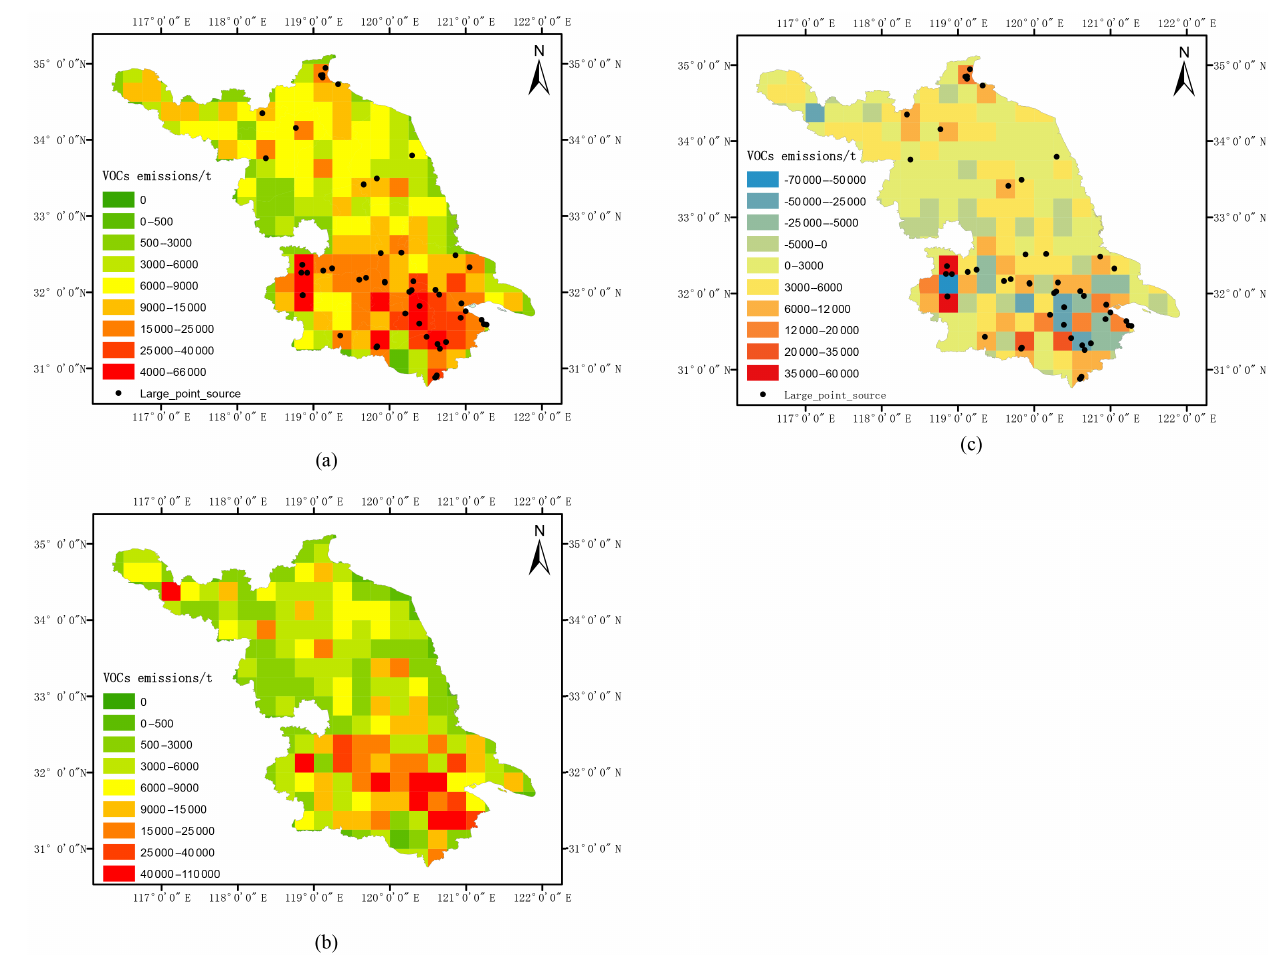
Figure 9. Spatial distributions of Jiangsu’s anthropogenic NMVOC emissions for 2010 (0.25 ◦ × 0.25 ◦ ) by this study (a) and MEIC (b) , and the differences between the two inventories (this study minus MEIC, c ). The black dots indicate the largest 50 emitters in the